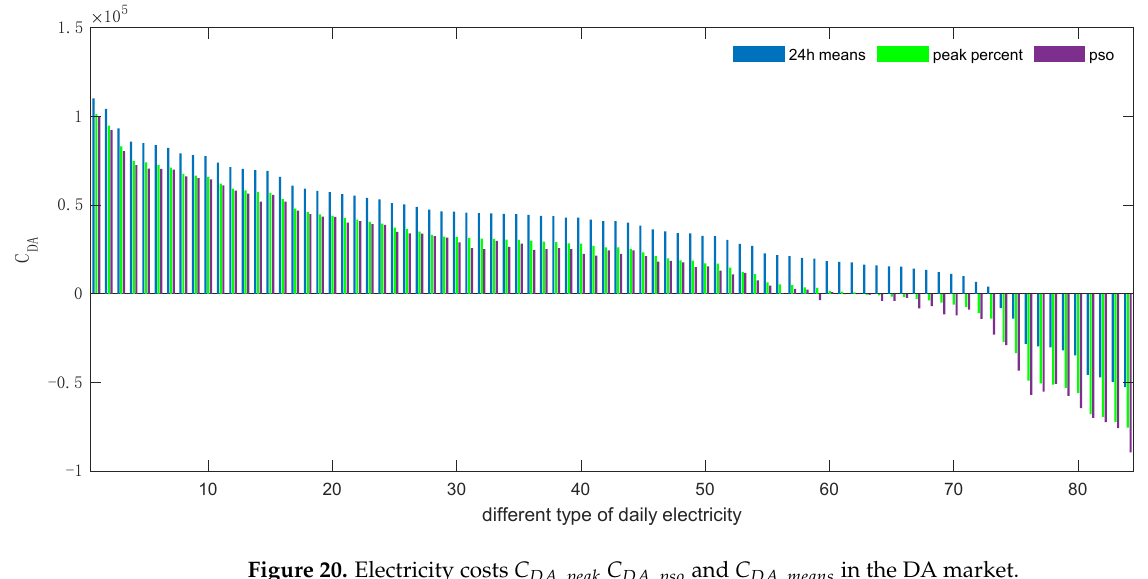
Figure 20. Electricity costs C DA _ peak C DA _ pso and C DA _ means in the DA